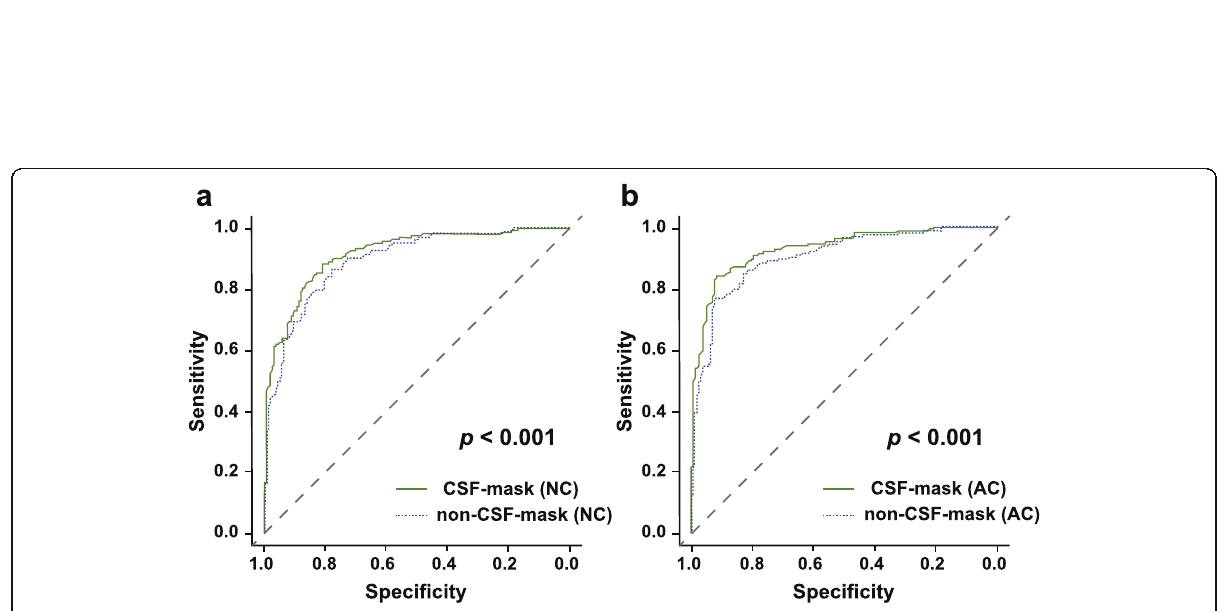
Fig. 4 ROC analysis of SBRs with and without the CSF-mask algorithm. The AUCs for the SBRs with and without the CSF-mask algorithm were 0.917 (95% CI 0.887 – 0.947) and 0.895 (95% CI: 0.861 – 0.929) in NC ( a ), and 0.930 (95% CI 0.902 – 0.957) and 0.903 (95% CI: 0.870 – 0.936) in AC ( b ), respectively. AC attenuation correction, CSF cerebrospinal fluid, NC no correction, ROC receiver-operating characteristics, SBR specific binding ratio, AUC area under the curve, CI confidence